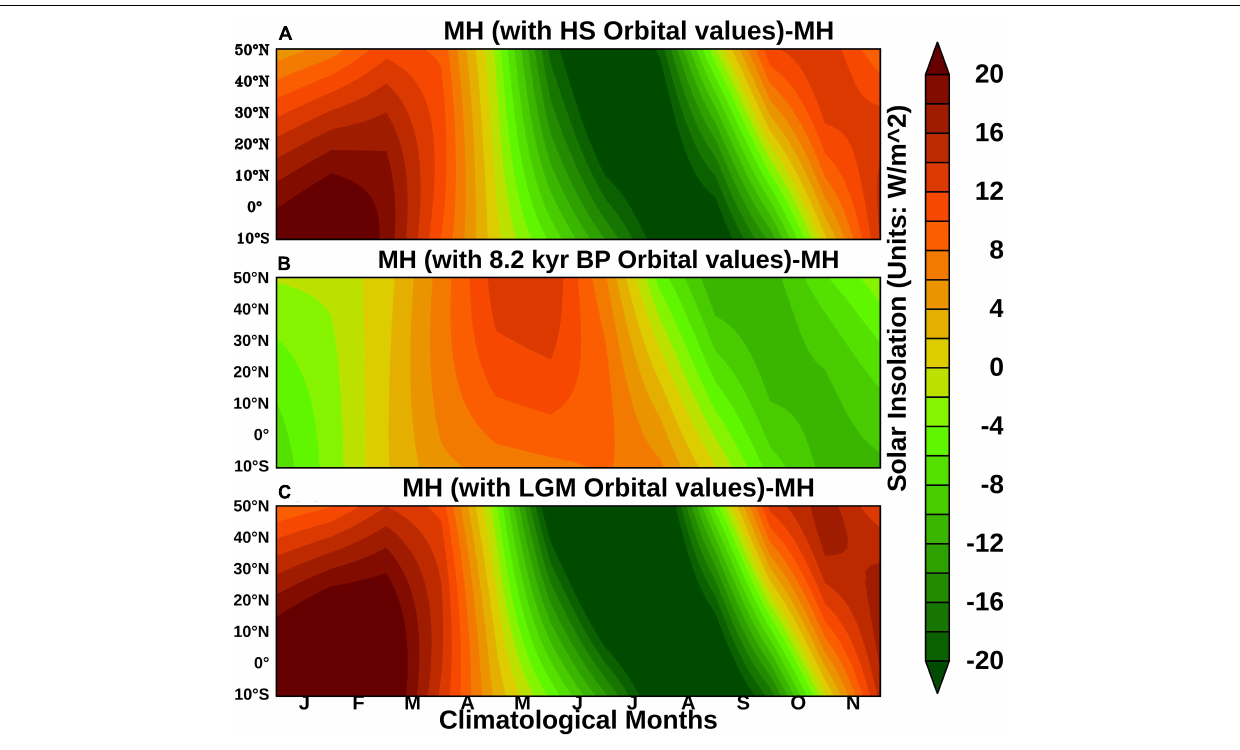
FIGURE 8 | Simulated insolation difference (W/m 2 ) between (A) MH sensitivity experiment with HS orbital parameters to MH control simulation, (B) MH sensitivity experiment with 8.2 kyr BP orbital parameters to MH control simulation, and (C) MH sensitivity experiment with LGM orbital parameters to MH control simulation. Averaged over all the longitudes (0 ◦ E to 360 ◦